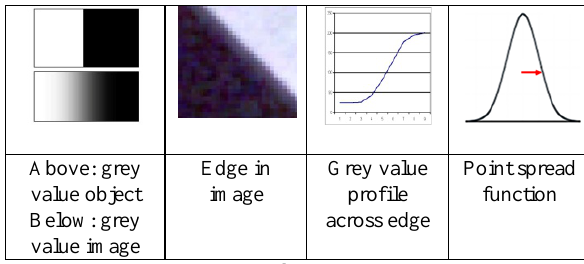
Fig. 11 : edge analysis – edge (cid:198) point spread function Some fused RGB-images have been analyzed for the effective resolution (Tab. 3). For the DMCII 230 the factors are slightly and for the DMCII 250 clearly below 1.0. That means there is no loss of resolution against the nominal resolution. The values for the different spectral bands are close together because they are dominated by the fused panchromatic band. The factors of the effective resolution of the DMCII 250 of approximately 0.86 indicate an image enhancement which is also shown by some image details. On the other hand no enlarged noise can be seen, which is only possible by the high quality optics with larger aperture especially designed for the individual camera